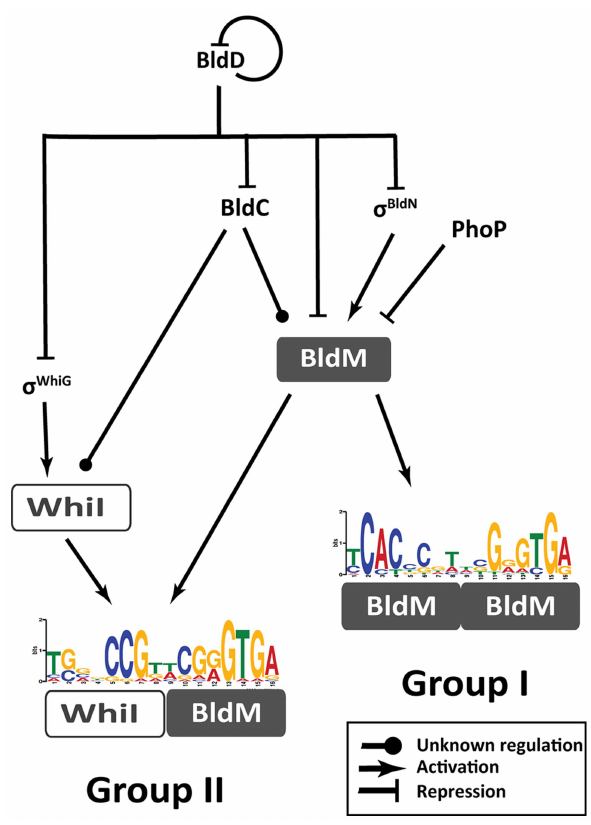
Figure 7. Schematic representation summarizing the regulato- ry network involved in controlling BldM and WhiI expression and the activation of Group-I and Group-II genes. During vegetative growth, BldD represses bldC , bldN , whiG and bldM . At the onset of differentiation, this repression is relieved, s BldN activates bldM and s WhiG activates whiI . BldM homodimer activates early sporulation genes such as whiB and ssgR . Subsequently, BldM and WhiI form a heterodimer that activates late sporulation genes such as whiE and smeA-sffA . Thus heterodimer formation serves to integrate signals from two independent pathways ( s WhiG -WhiI and s BldN -BldM). bldM expres- sion is tightly controlled by at least four global regulators - BldD, BldC, s BldN and PhoP (a response regulator activated during phosphate depletion [59]).